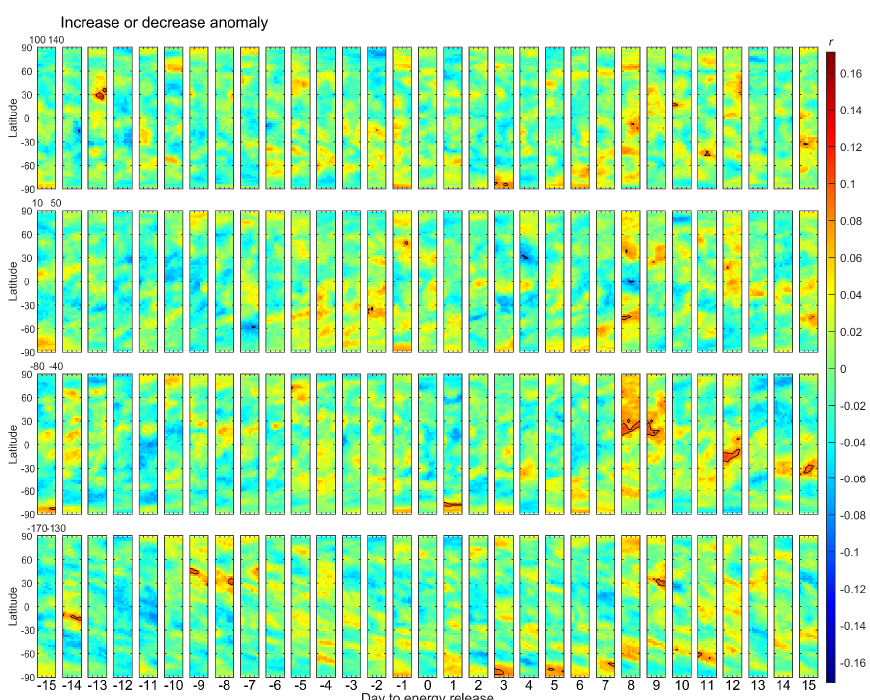
Figure 3. Same as Figure 2 for the results of occurrence times of TEC increase anomalies.